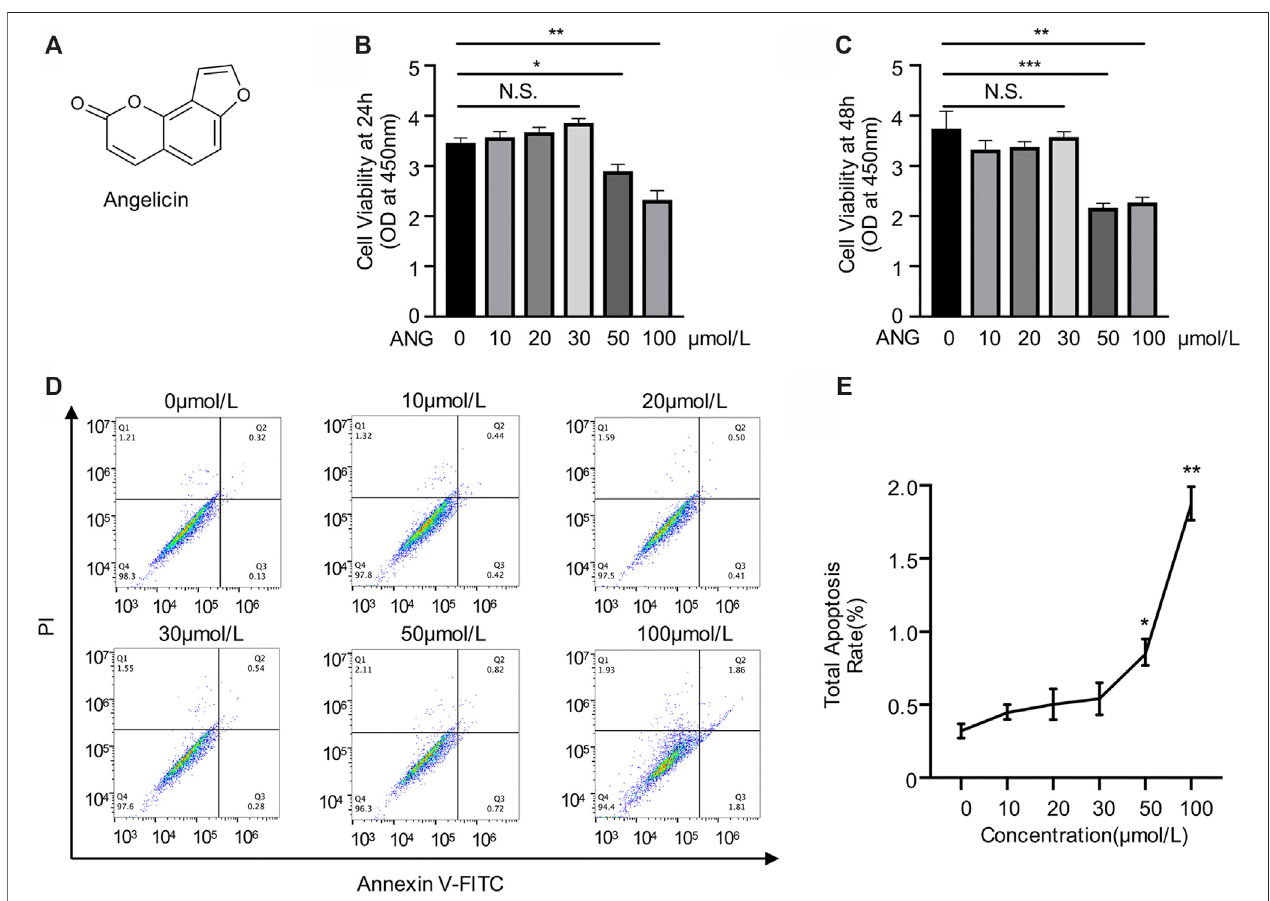
FIGURE1| Evaluationofangelicintoxicityinbonemarrowmacrophages(BMMs). (A) Chemicalstructureofangelicin. (B,C) Effectofangelicinonthecellviabilityof BMM. Thecytotoxic effects ofangelicin weredetected atthe differentconcentrationsfor24and 48 h using CCK-8 assay. (D,E) Representative imageofapoptosis rate detected by fl ow cytometry of each group. The values presented are the mean ± SD of fi ve independent experiments. * p < 0.05, ** p < 0.01, *** p < 0.001 (ANOVA).